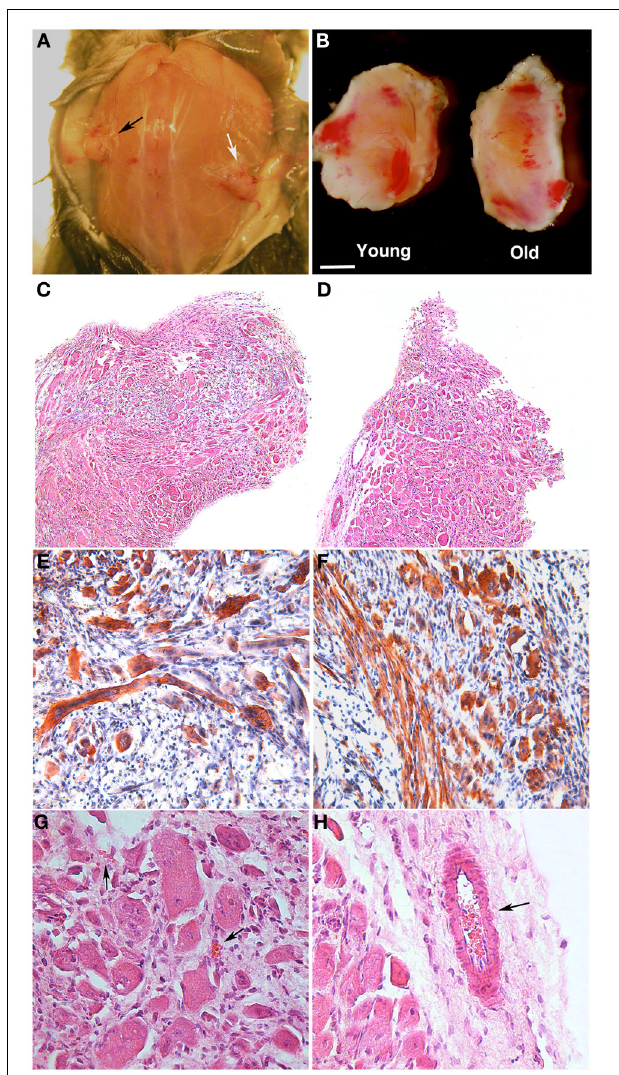
FIGURE 5 | PEG-fibrinogen-pericyte constructs form ectopic muscle in vivo . Muscle-derived pericytes (MP) seeded onto PEG-fibrinogen scaffolds (MP + PF) were implanted subcutaneously in immunocompromised mice and extracted 30 days after grafting ( n = 6). (A,B) Macroscopic comparison of subcutaneous MP + PF implants loaded with 5 × 10 5 young MP (black arrow) and 5 × 10 5 adult MP (white arrow) (A) , revealing an ectopic, vascularized tissue-like formation (B) . (C,D) Hematoxylin/eosin stained sections of ectopic tissue revealing similar muscular-like structures generated from young (C) and adult (D) MP. (E,F) Immunohistochemistry on young- (E) and old- (F) MP-derived ectopic tissue showing muscle fiber positive for myosin heavy chain (red/brown). Nuclei stained with hematoxylin (blue). (G,H) Enlarged view of, respectively (C) and (D) , revealing the presence of vessels (arrows) in a muscle-like tissue. Scale bar: (A) 10mm; (B) 2.5mm; (C,D) 300 μ m; (E,F) 100 μ m; (G,H) 50 μ